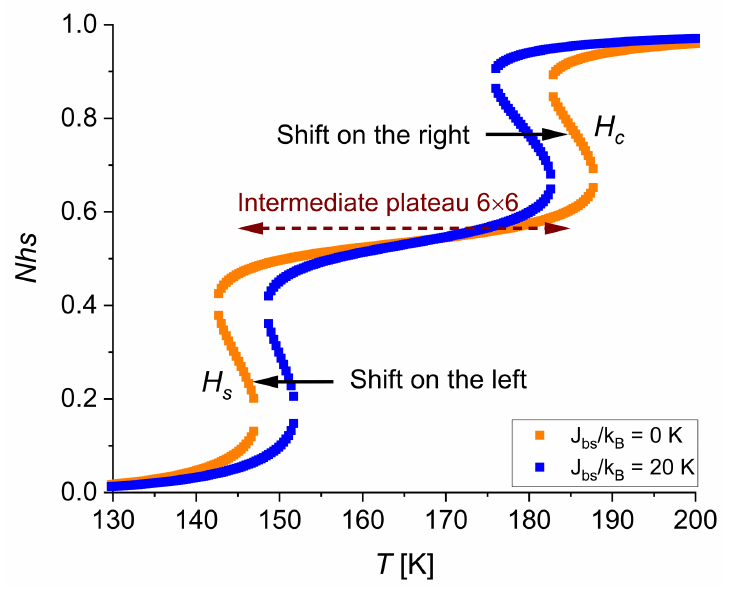
Figure 9. Thermal evolution of the HS fraction in the case of a 6 × 6 lattice for J bs / k B = 20 K (blue squares) and J bs / k B = 0 K (orange squares). The computational parameters are: ∆ / k B = 1300 K, L / k B = 290 K, G / k B = 172 K, J bb / k B = 60 K, J ss / k B = 50 K and ln( g ) =